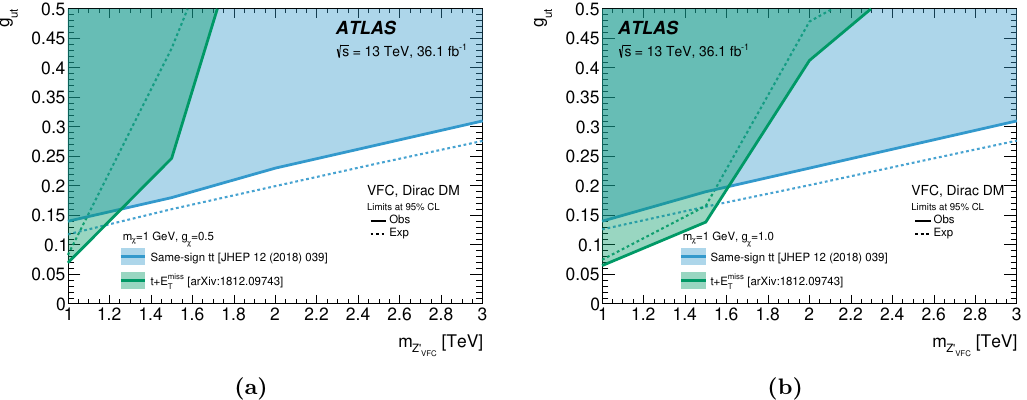
Figure 15. Exclusion regions in the ( m for the VFC model. The observed exclusion is indicated for each of the two analyses by the (cid:12)lled area. The mass of the DM particle is set to 1 GeV and the DM coupling, g (cid:31) , is set to (a) 0.5 or (b) 1.